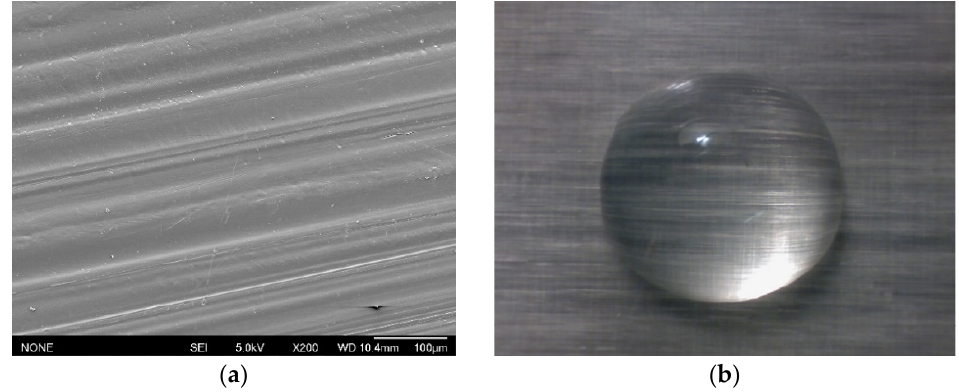
Figure 7. ( a ) SEM image of GFPA6 surface morphology, and ( b ) image of GFPA6 surface covered with a 6 μ L water droplet.